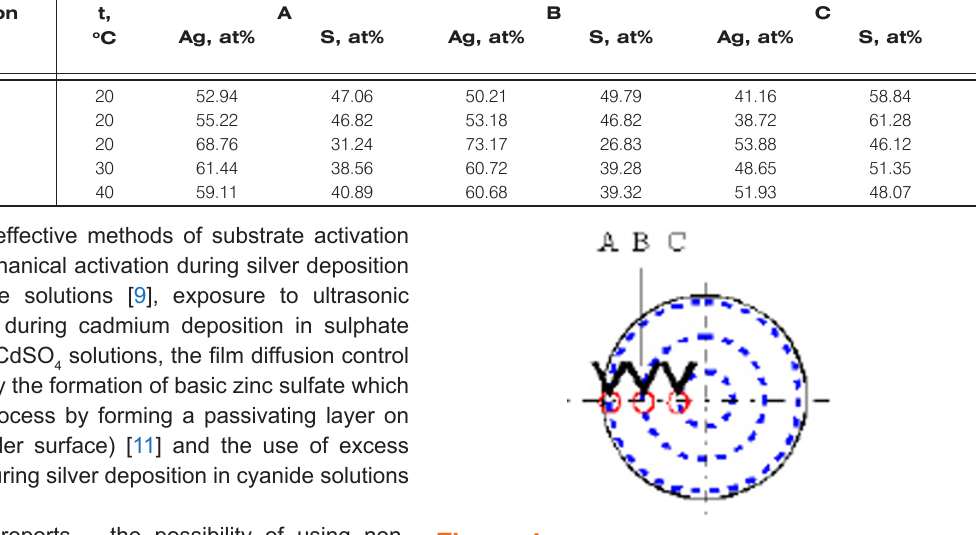
Figure 1. Scheme of magnesium disk microlocal parts for SEM micrographs investigation. A, B, C positions were the distances from the disc edge: 1 – 2; 6 – 7 and 11 – 12 mm, correspondently.